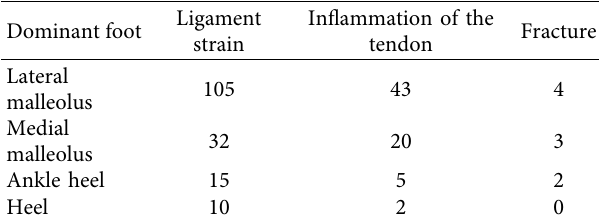
Figure 5: Improved algorithm under different data set sizes. Table 1: Types of injuries on the side of the dominant